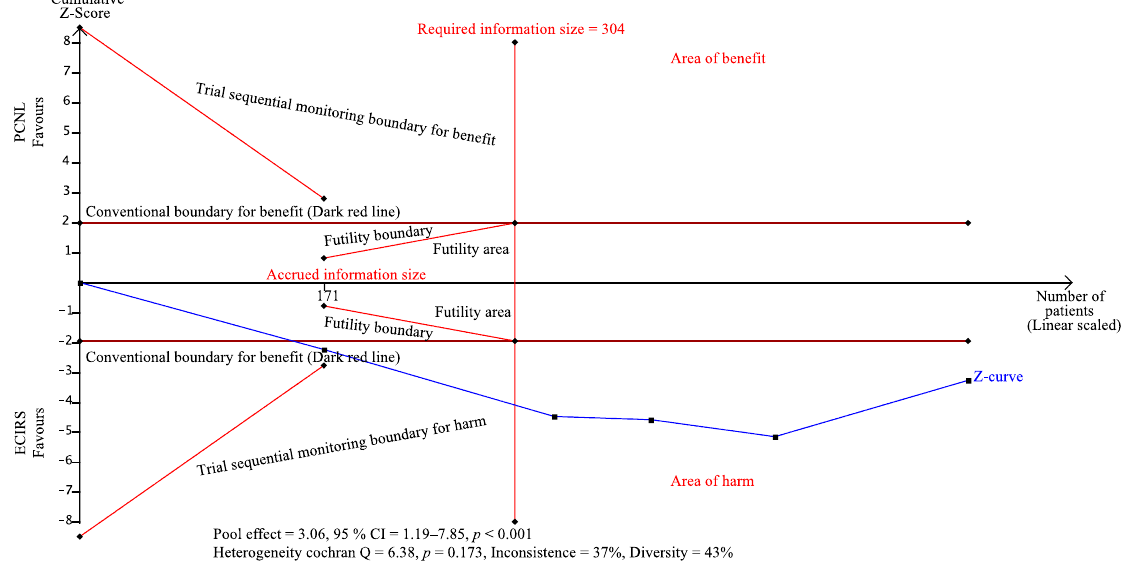
Figure A47. Trial sequential analysis of outcome regarding final stone free rate.